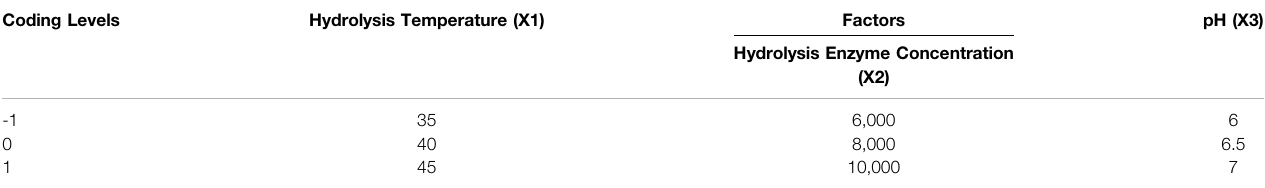
TABLE 1 | Factors and level of response surface